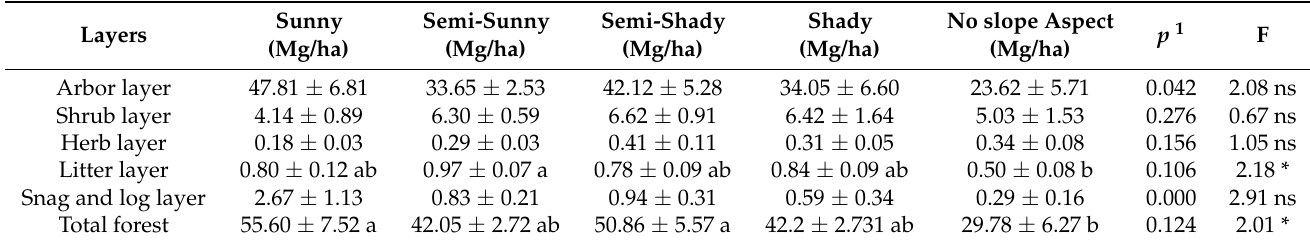
Table 9. Differences of vegetation carbon density between slope aspect gradients.